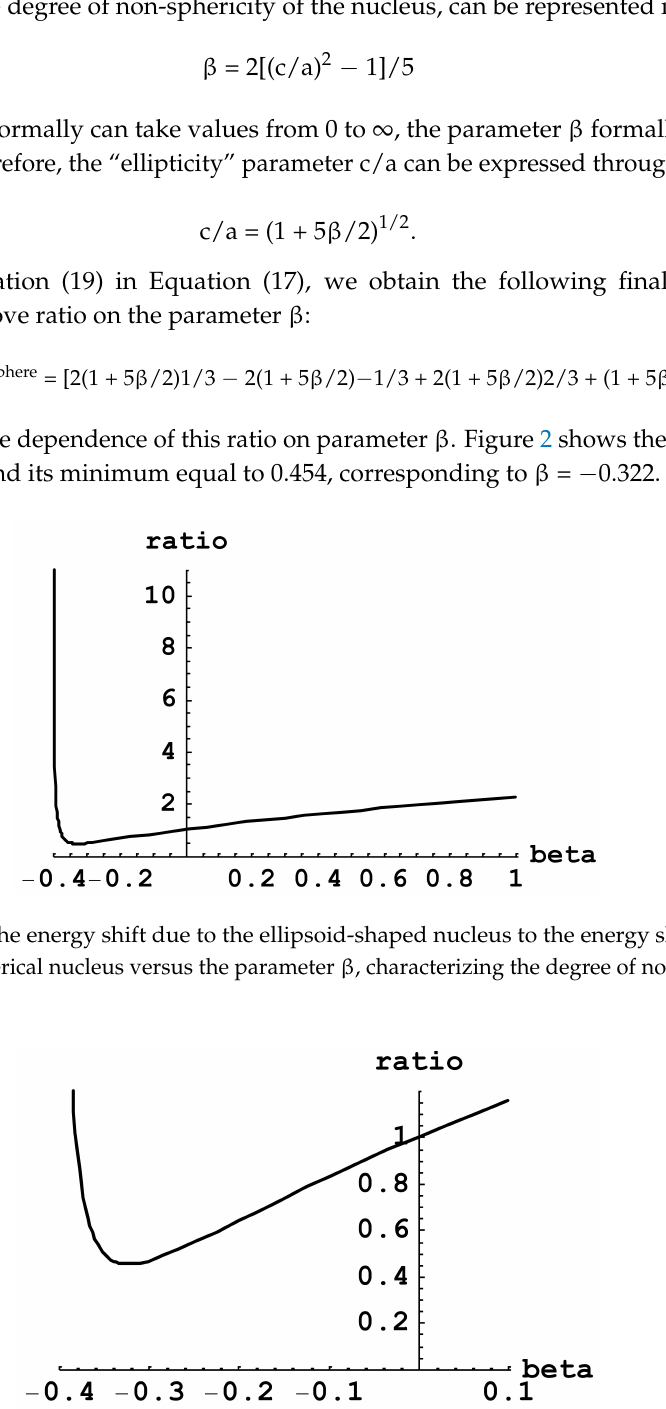
Figure 2. The magnified part of the dependence from Figure 1 around the minimum of this dependence, which is equal to 0.454 and corresponds to β = −